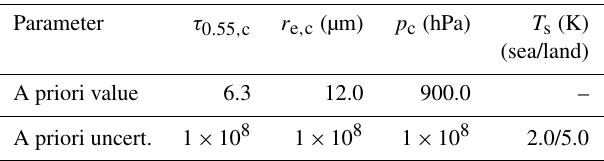
Table 5. Liquid water cloud a priori values and associated uncer- tainties.